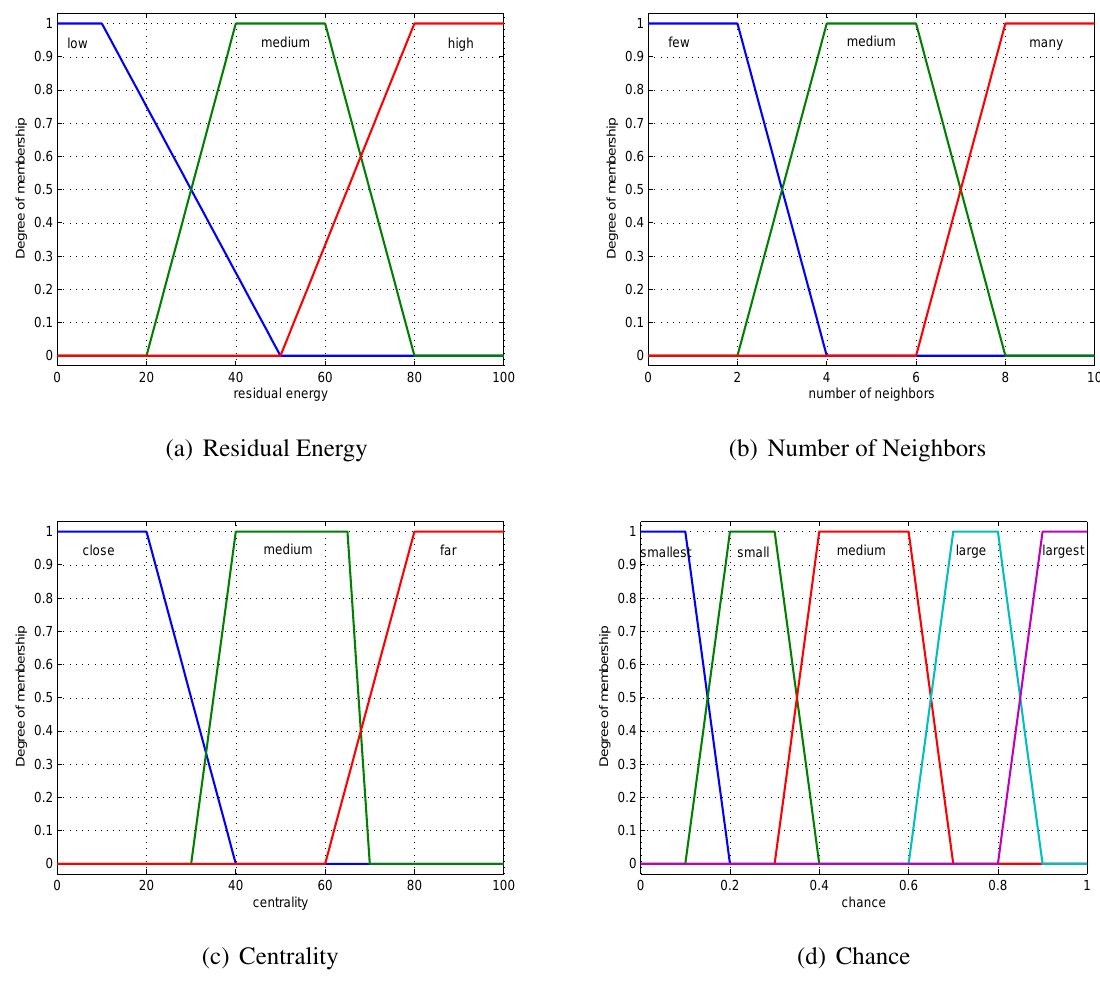
Figure 5. Membership functions of the fuzzy